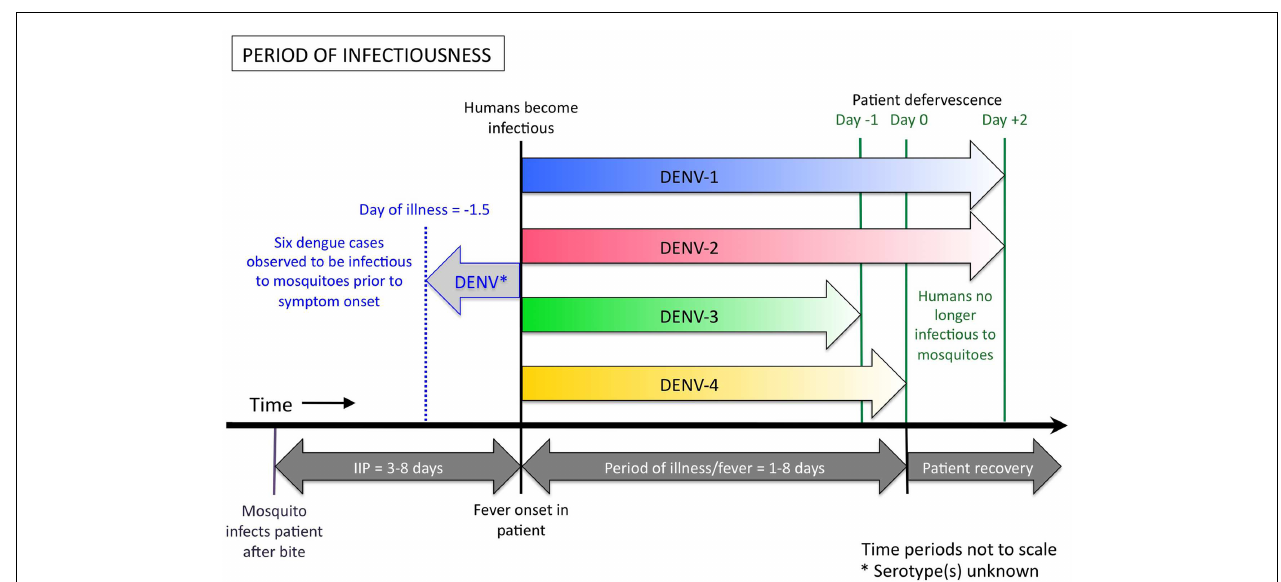
becomes afebrile, however DENV-3 (green) and DENV-4 (yellow) appear to be less infectious at these later stages of illness, due to lower plasma viremia in the patient. A single study (37), found that six dengue patients were infectious to mosquitoes from 0.25days, up to a maximum of 1.5days, before they had any sign of symptoms (indicated by the pale gray arrow).The serotype of virus used in Siler et al.’s study is unknown. Below the black line is the relative alignment of the course of dengue illness. IIP = intrinsic incubation